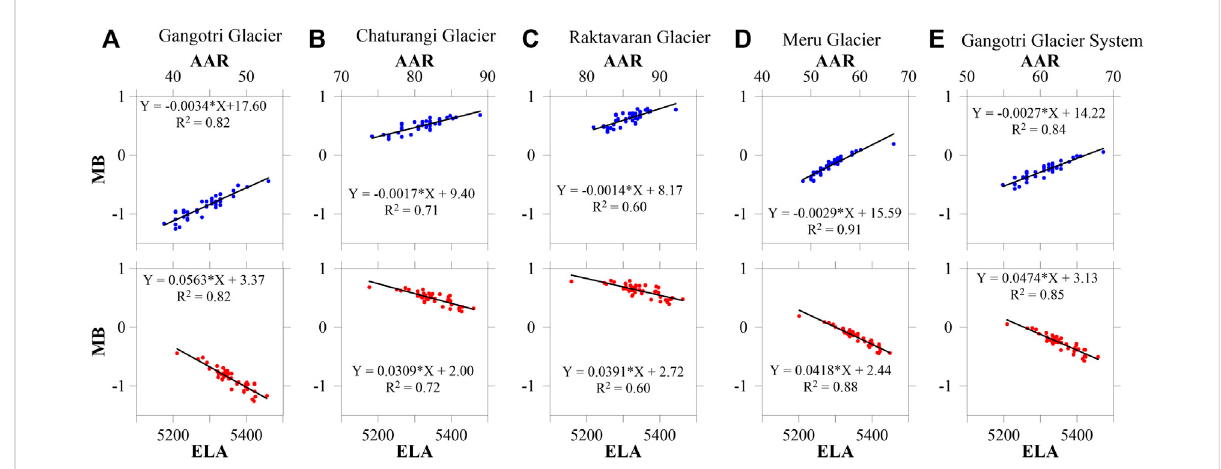
FIGURE 6 ELA (in m a.s.l.) and AAR (in %) relationship with the annual MBs for (A) Gangotri Glacier, (B) Chaturangi Glacier, (C) Raktavaran Glacier, (D) Meru Glacier and (E) Gangotri Glacier